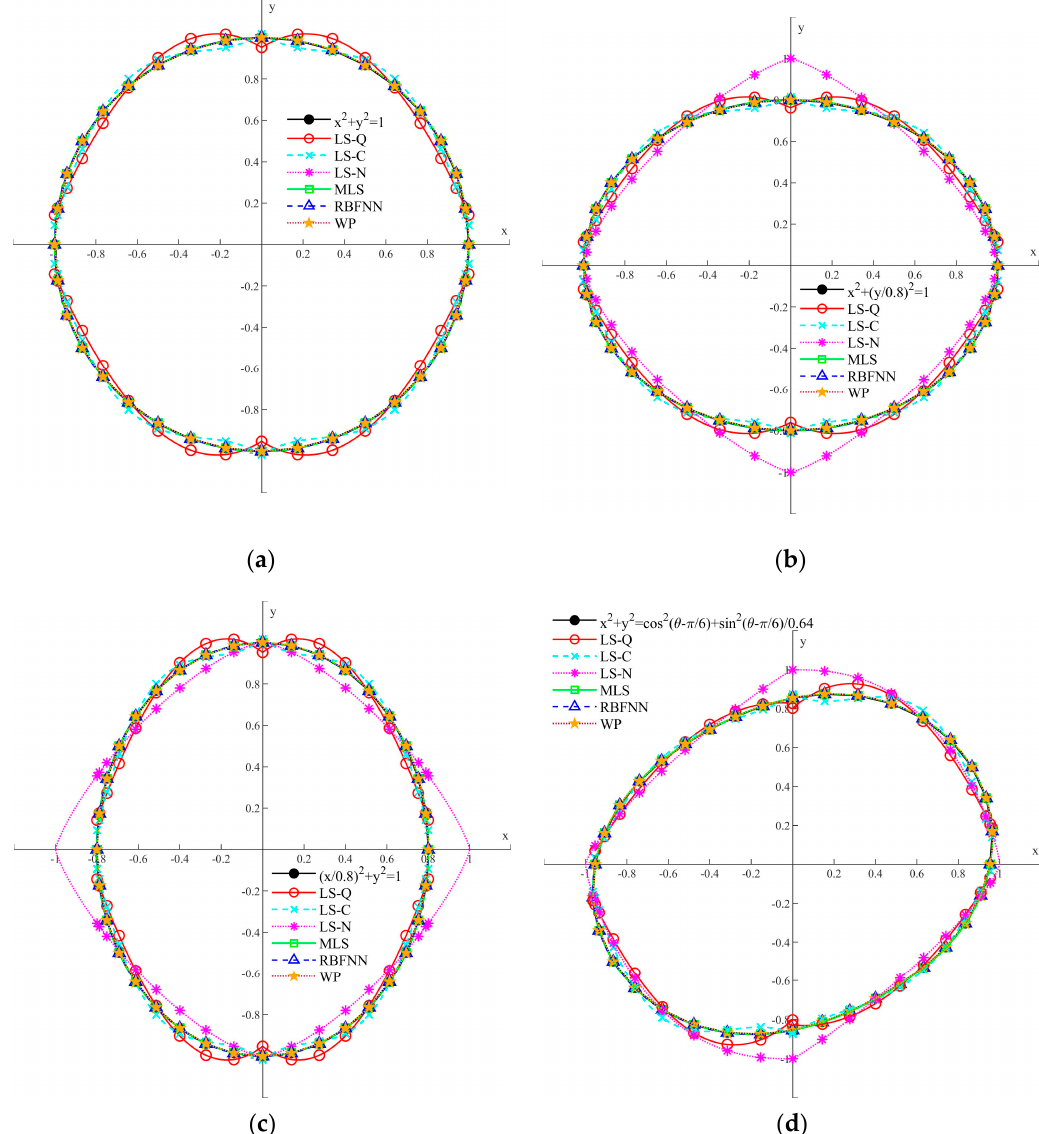
Figure 3. Fitting results for ( a ) TD1, ( b ) TD2, ( c ) TD3, and ( d ) TD4.